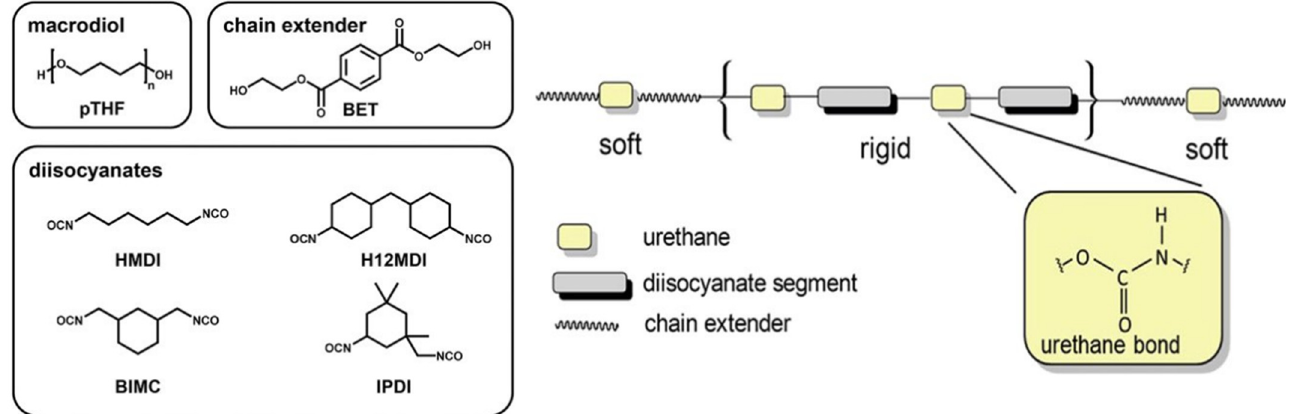
Figure 3. Chemical structure of polyurethanes. ( left ) The basic components of polyurethanes [49]. ( right ). Structure of the elastomer thermoplastic polyurethane which contains hard and soft segments [50]. Reprinted with permission from Ref. [50]. Copyright 2020 Springer Science Business Media.